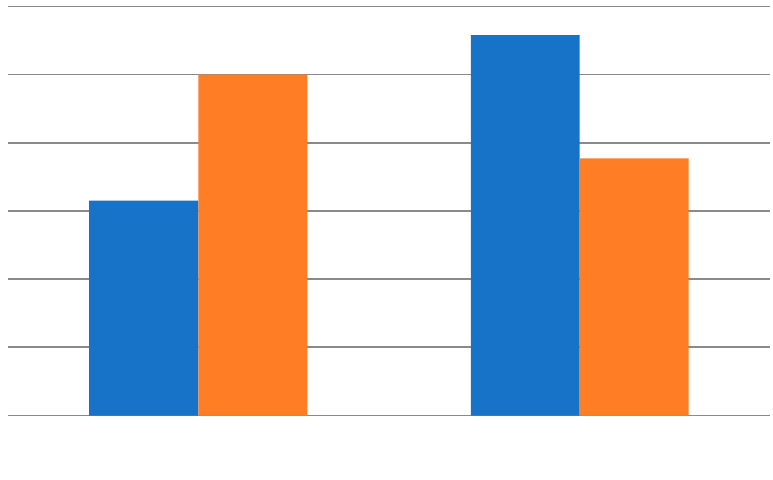
Figure 9. Antifouling parameters of kaolin membranes.